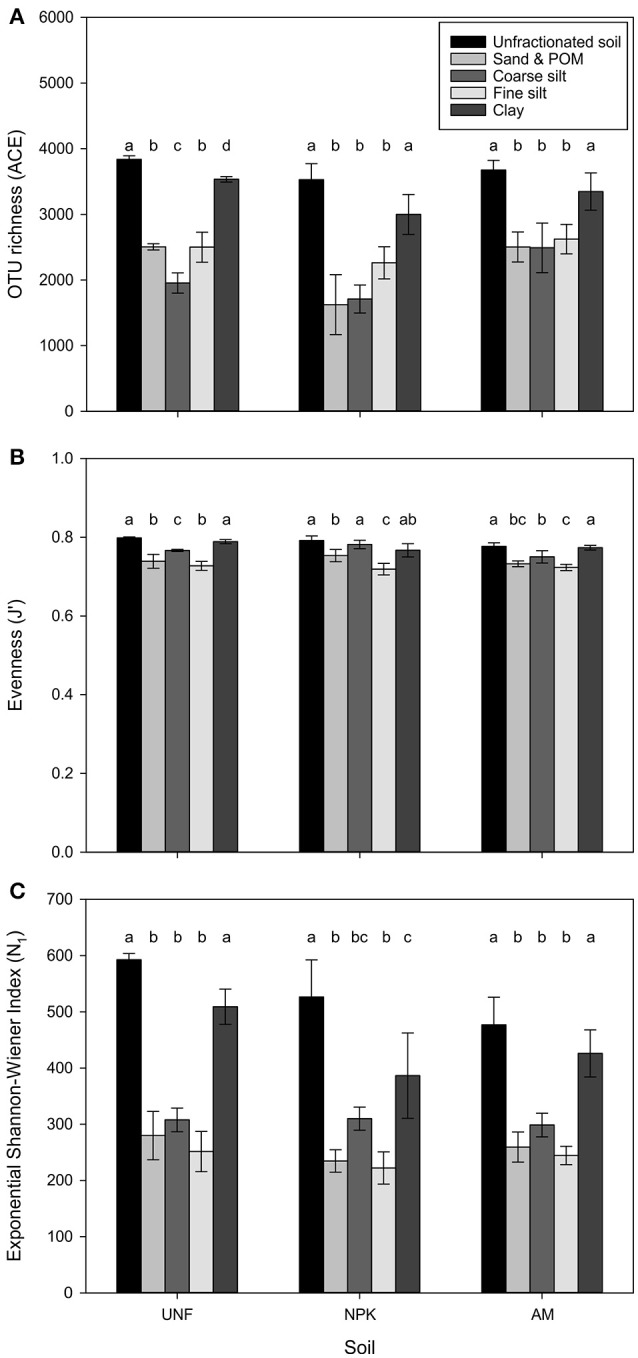
Estimates of bacterial OTU richness using the abundance-based coverage estimator (ACE) (A), evenness (J′) based on the Shannon-Wiener Index (H′) (B), and diversity H′ expressed in exponential form (eH′ = N1) (C) for three treatments, i.e., unfertilized soil (UNF), mineral fertilized soil (NPK), and animal manured soil (AM). Libraries were rarefied to 46,205 sequences. Error bars represent standard deviations of technical replicates and different letters significant differences between them for each fertilization treatment. The overall p-values between fractions across treatments was <0.001 each (FACE = 61.32, FJ′ = 38.95, FN1 = 80.61).